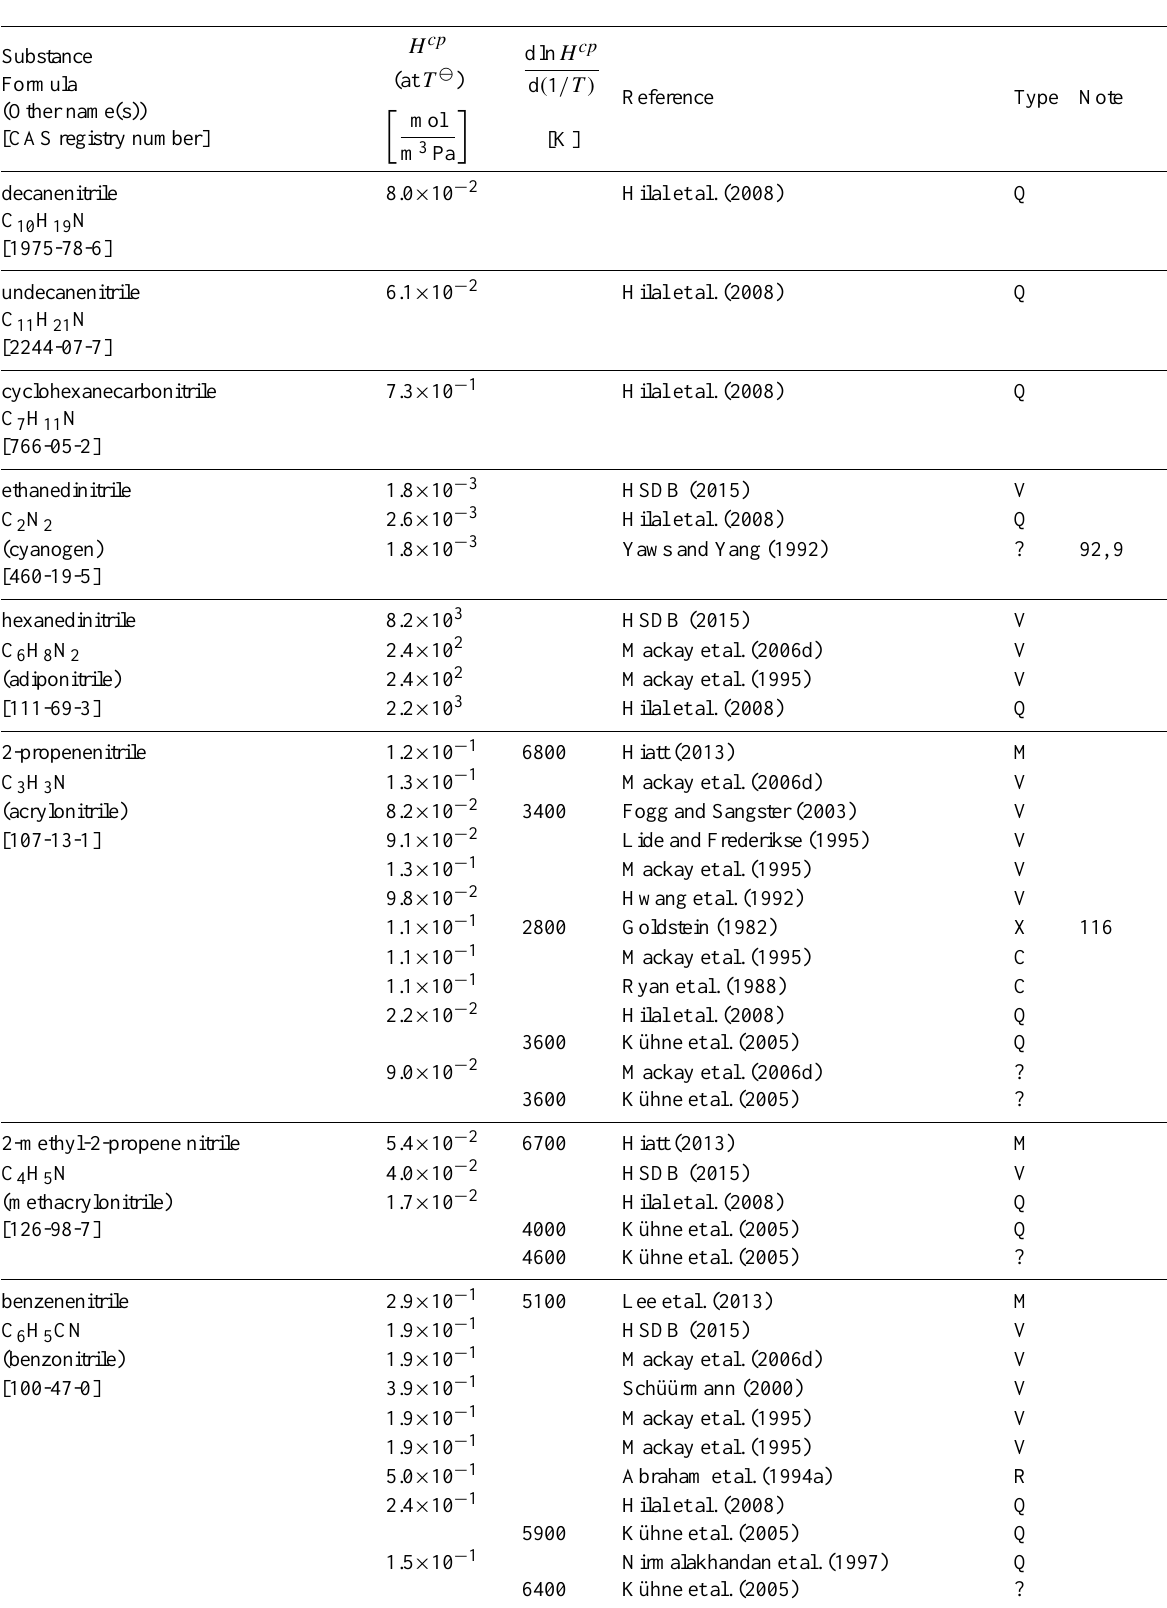
Table 6: Henry’s law constants for water as solvent